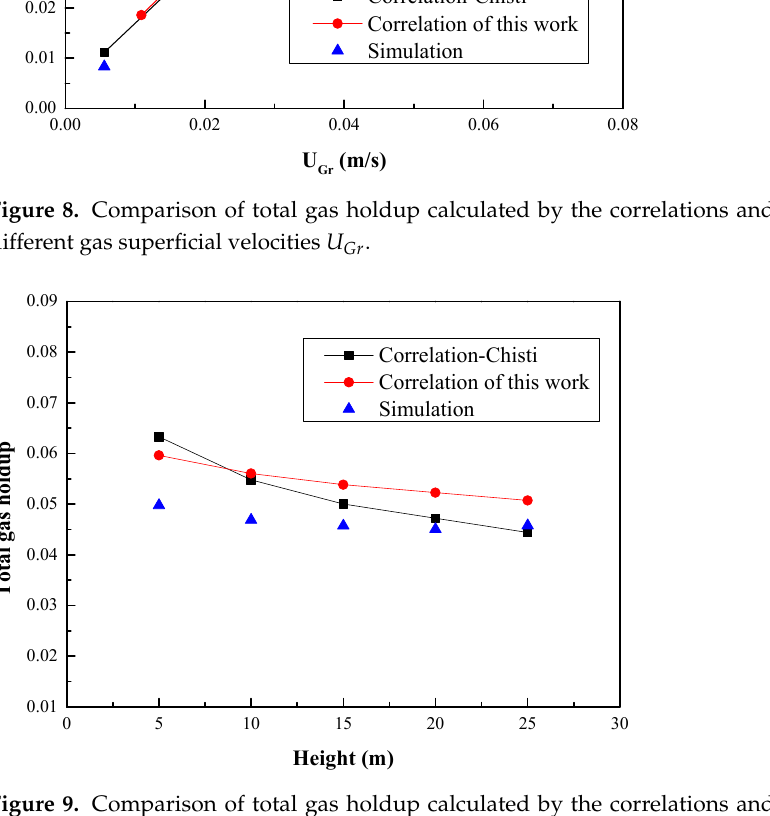
Figure 9. Comparison of total gas holdup calculated by the correlations and CFD simulation at different total column heights.